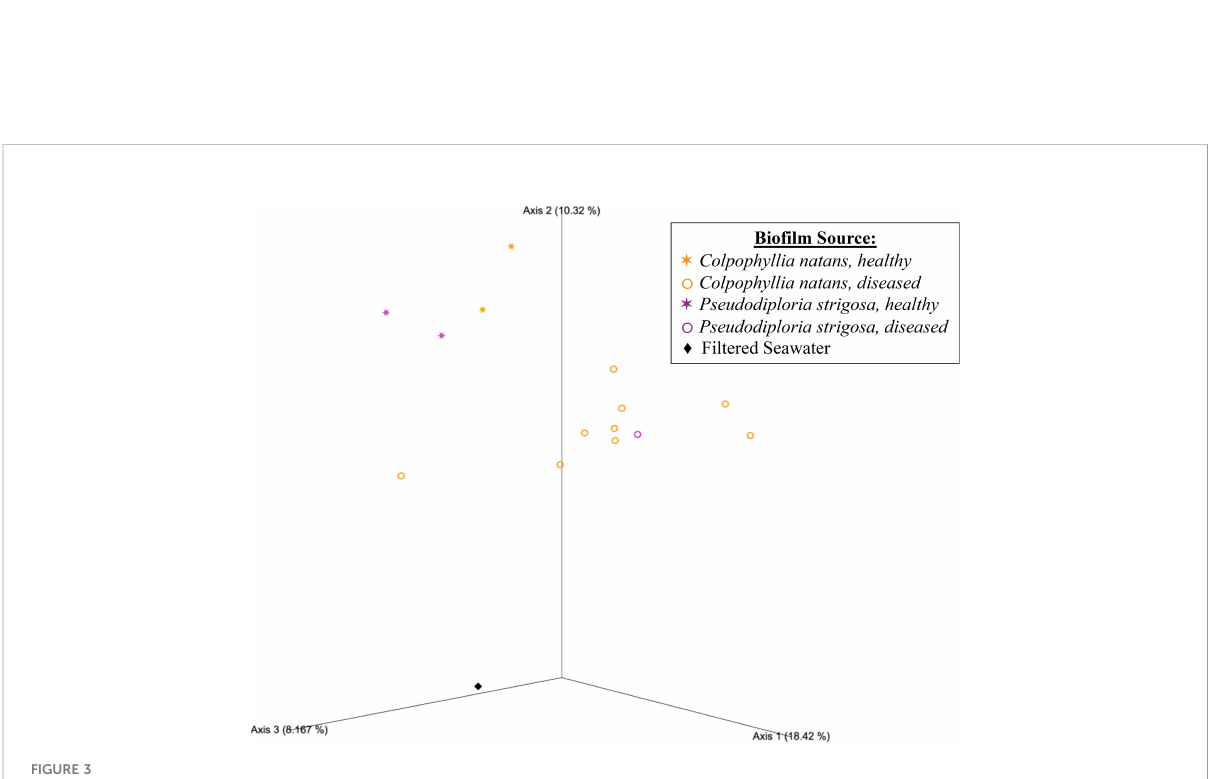
Overall permutational multivariate analyses of variance (PERMANOVA) tests and dispersion (PERMDISP) tests are shown based on weighted and unweighted UniFrac distance matrices, with subsequent pairwise PERMANOVA tests conducted for all signi fi cant PERMANOVA results. All signi fi cant test outcomes (p < 0.05, q < 0.05) are indicated by